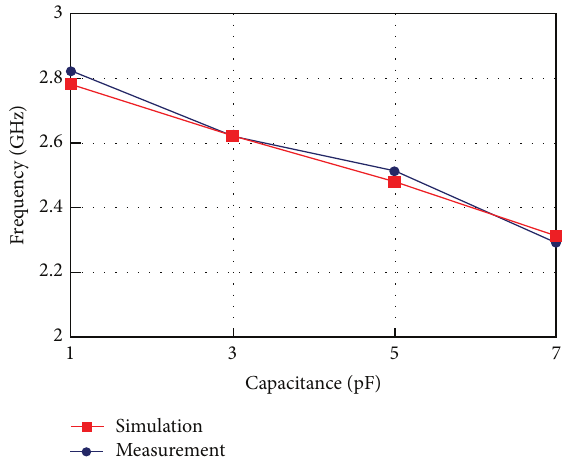
Figure 5: Relationship between the resonant frequency and the loaded